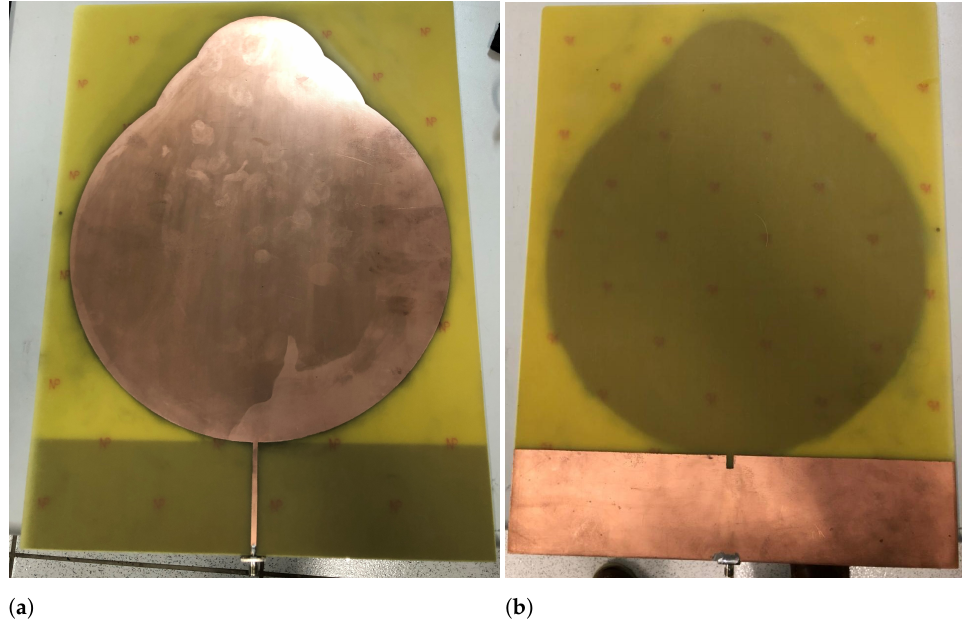
Figure A3. Optimized antenna designed with right angles ground plane: ( a ) front view and ( b ) back